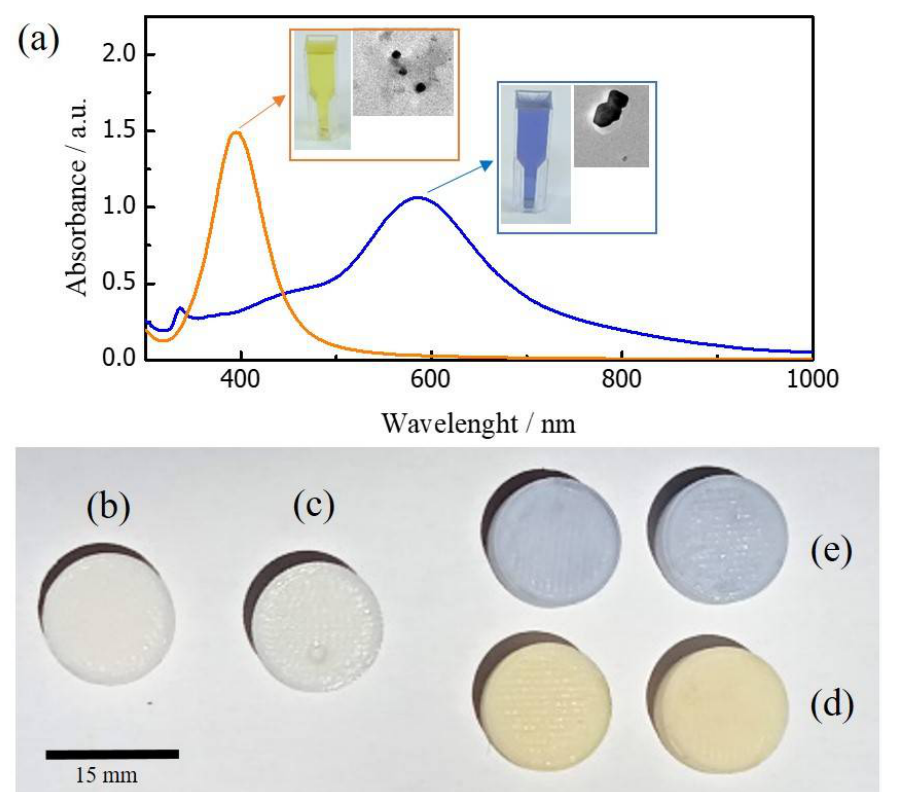
Figure 2. Top: ( a ) UV/Vis spectra of ex-situ synthesized catalyst. Orange spectrum: standard AgNPs, blue spectrum: photo-illuminated bigger clusters. Insets: Colloid picture and exemplary TEM image of AgNPs. Bottom: ( b ) 3D-printed sample, ( c ) 3D-printed sample without etching, but through impregnation procedure. 3D-samples after etching and impregnation process with standard ( d ) and photosynthesized Ag clusters ( e ).